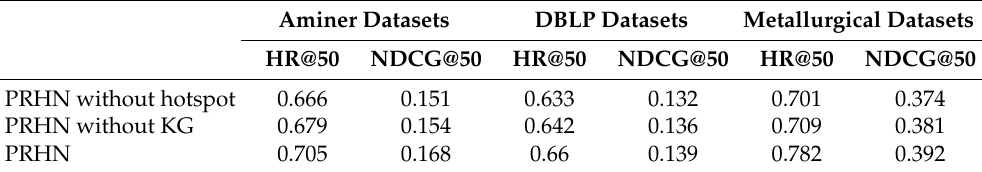
Table 5. Performance of different models on metallurgical datasets.